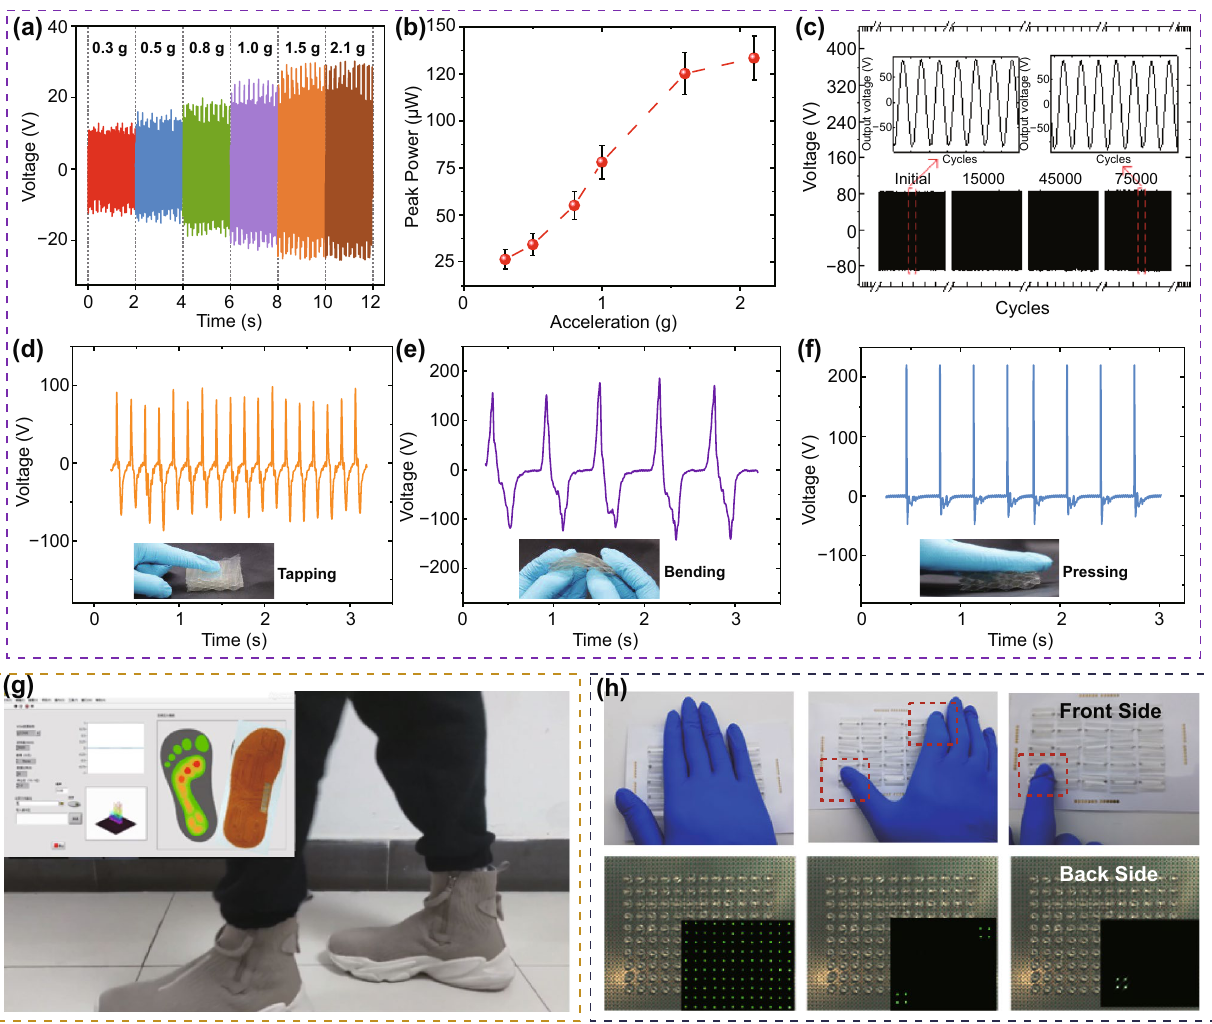
Fig. 5 a , b Output voltage waveforms and magnitudes versus different excitation accelerations in the range of 0.3 ~ 2.1 g. c Output voltages of proposed h-TENG under continuous operations for ~ 75,000 cycles at an excitation acceleration of 5 g and a frequency of 30 Hz. d – f Output sig- nal characteristics of proposed h-TENG by human motions, such as finger touching, bending and tapping. g Snapshot of real-time insole plantar pressure mapping using an array of h-TENGs during human walking. h Lighten up 10 × 10 LED display panel by 5 × 5 h-TENG array for instan- taneous hand force mapping, when the whole palm, one finger or two fingers touch the generator